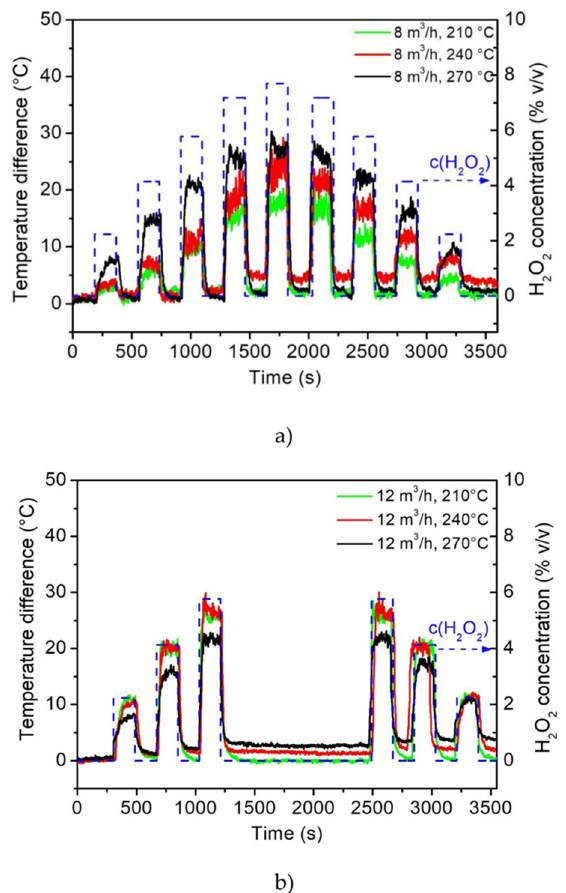
Figure 3. Assessing the calorimetric gas sensor signals and, consequently, the H 2 O 2 concentrations (0, 2.2, 4.1, 5.7, 7.1/6.6 and 7.7% v/v ) under varying gas flow rates (8 m 3 /h ( a ) and 12 m 3 /h ( b )) at temperatures of 210, 240 and 270 °C, respectively.